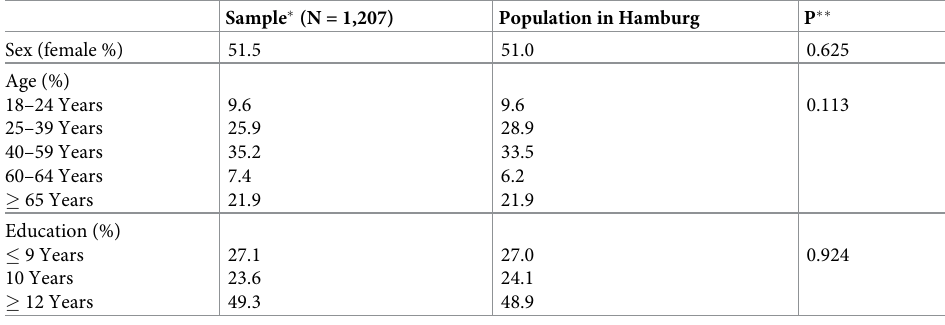
Table 1. Distribution of sociodemographic characteristics of the sample compared with official statistics for the population in